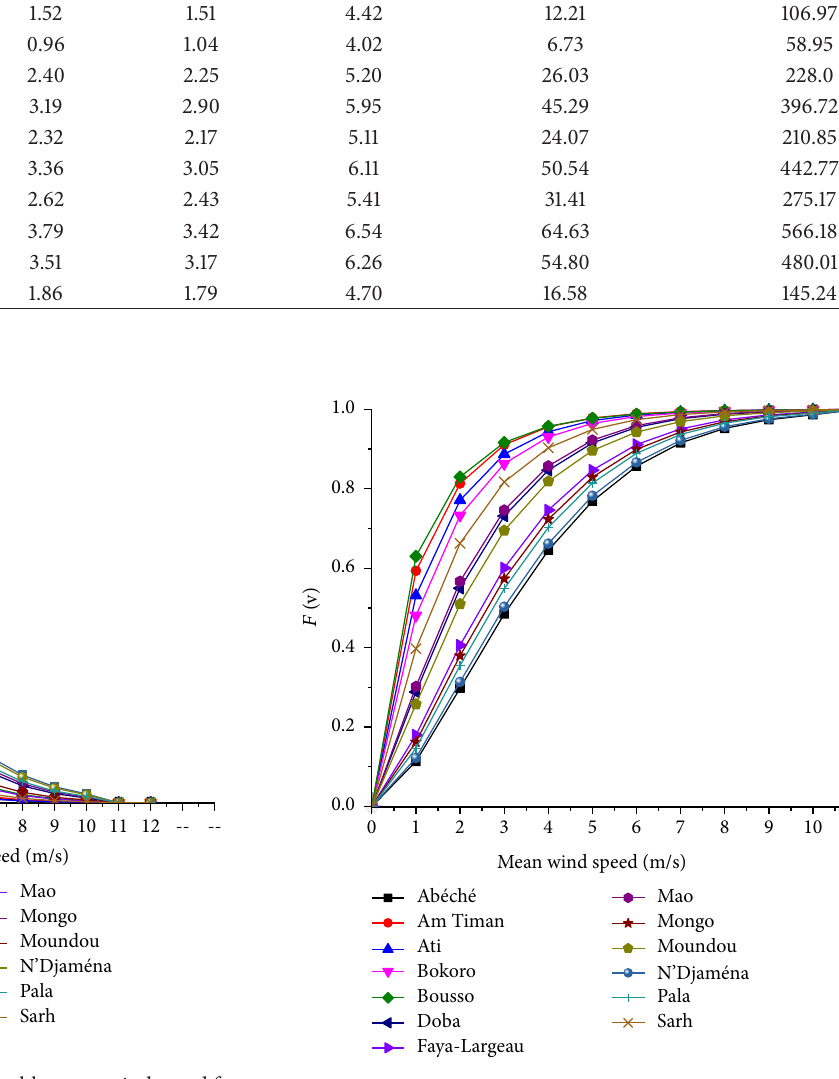
Figure6:Cumulativedistributionsofmonthlymeanwindspeedfor all